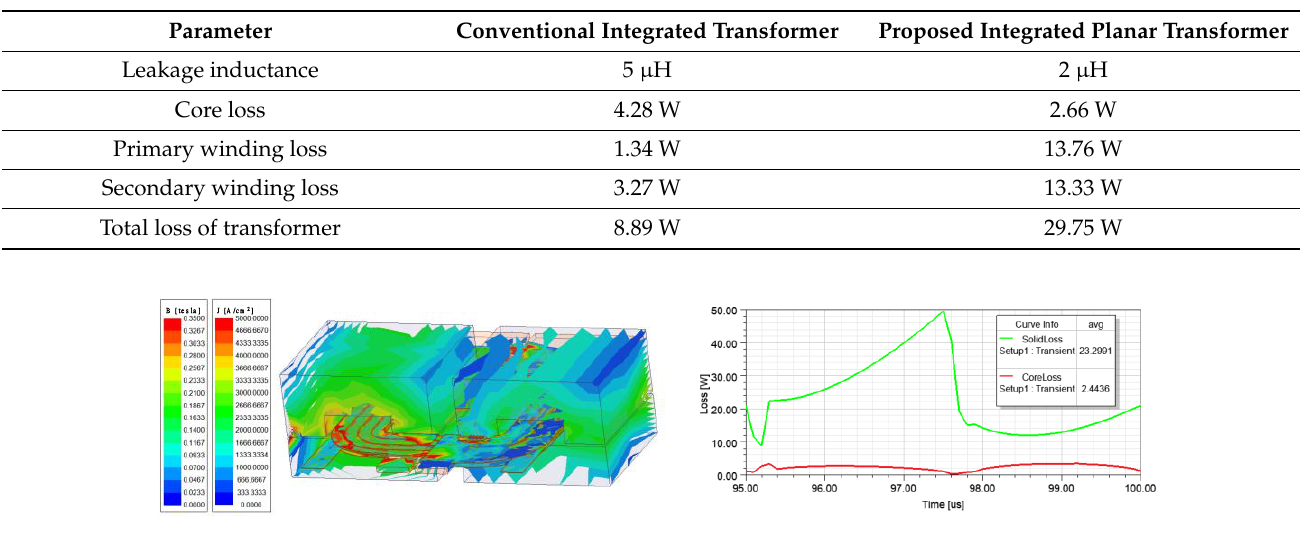
Figure 10. Planar transformer core and conduction loss simulation at 270 V input and full load conditions.